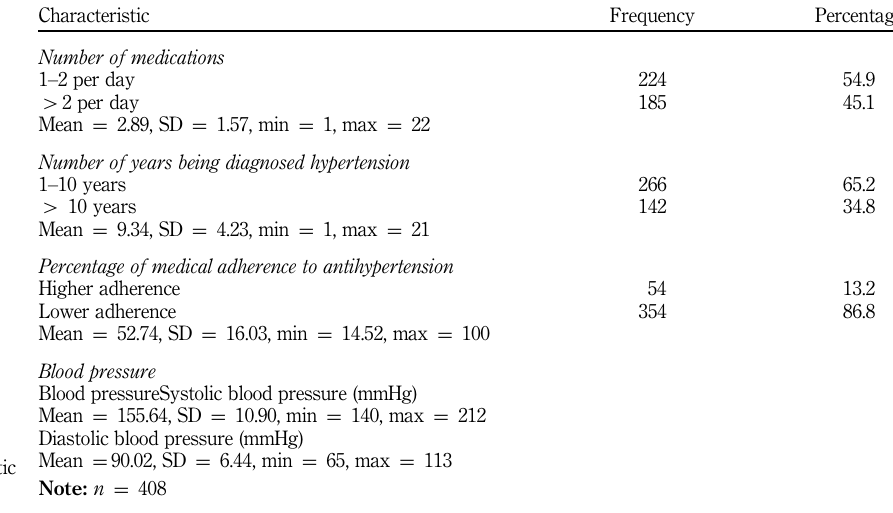
Table II. Medical characteristic of